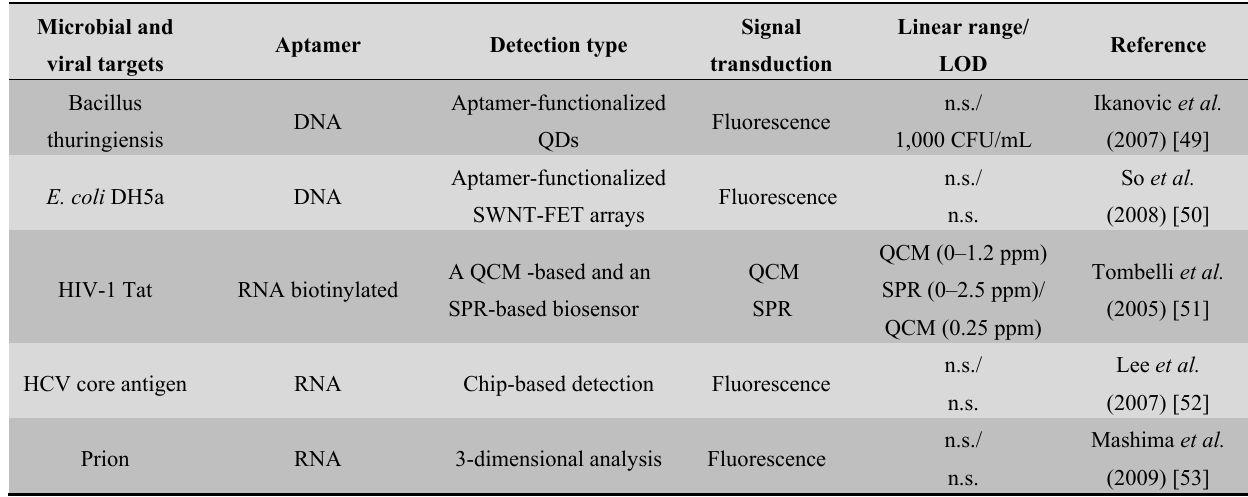
Table 3. Examples of application of aptasensors for detection of microorganisms and